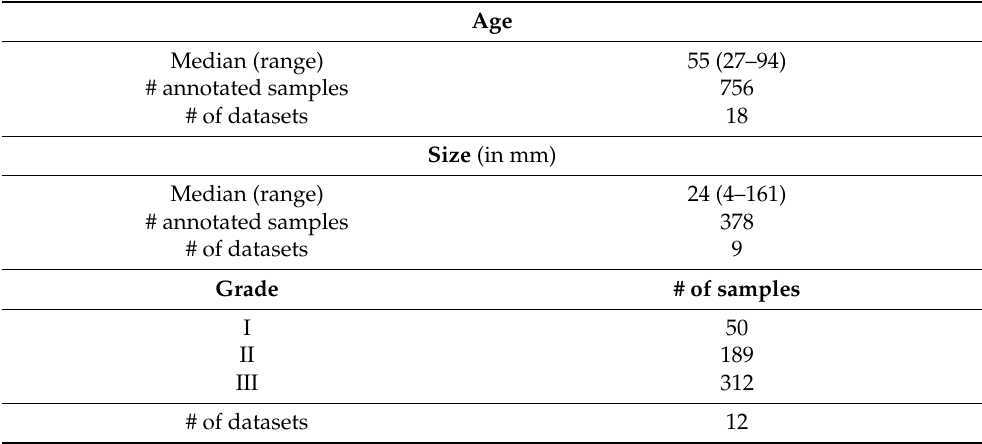
Table 2. Summary of clinical features for primary tumor samples (complete list in Table